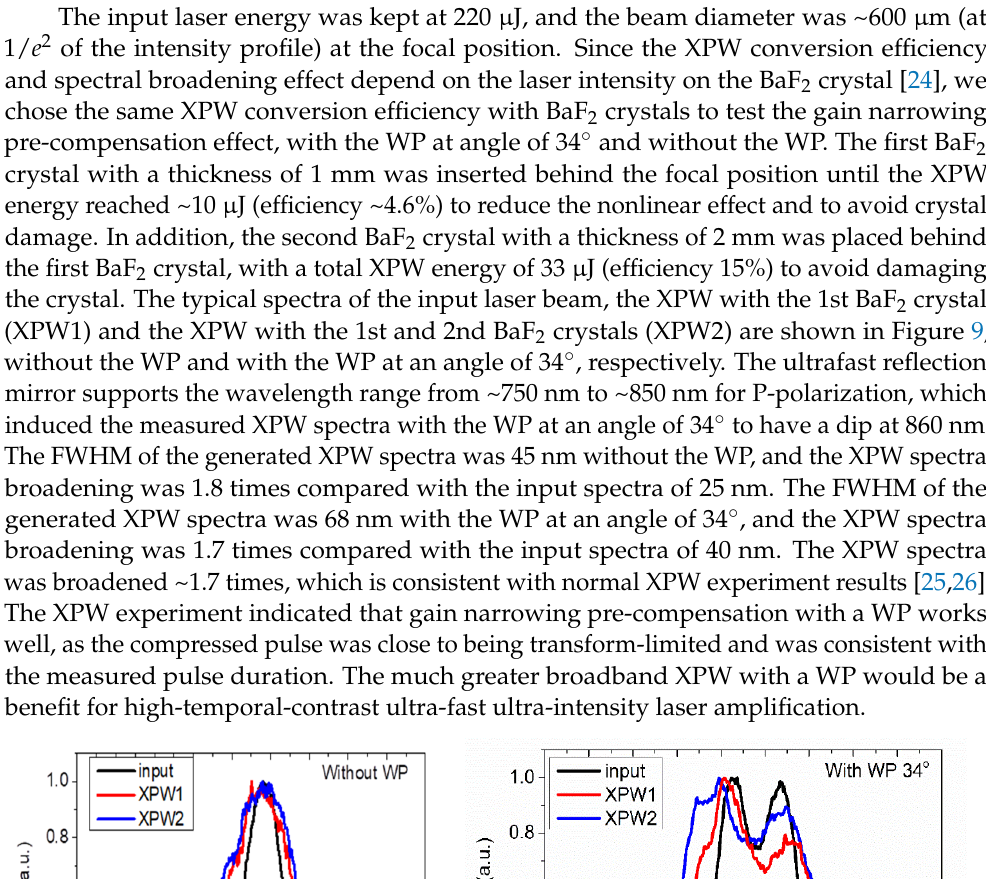
Figure 8. The layout of the XPW generation system with two BaF 2 crystals in the air. HWP is the zero-order half waveplate, and M1 and M2 are 45° reflection ultrafast laser mirrors.